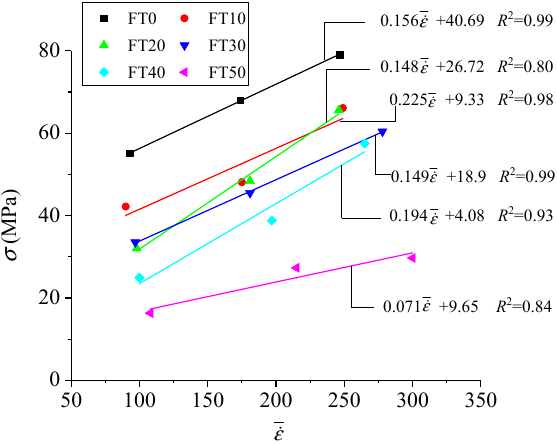
Figure 9. Variation rules of dynamic peak stress with strain rate.